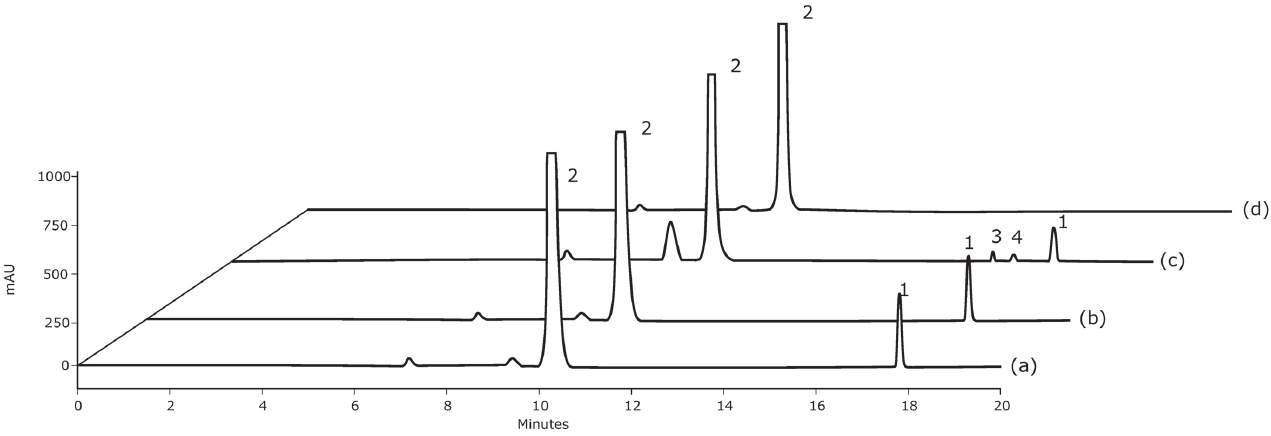
FIGURE 2 – Representative SE − LC chromatograms showing peak 1 = rhIFNβ − 1b; peak 2 = human serum albumin; peaks 3 and 4 = high − molecular − weight substances. (a) Biological reference substance of rhIFNβ − 1b. (b) Sample of biopharmaceutical formulation, untreated and after: (c) neutral hydrolysis; (d) placebo.